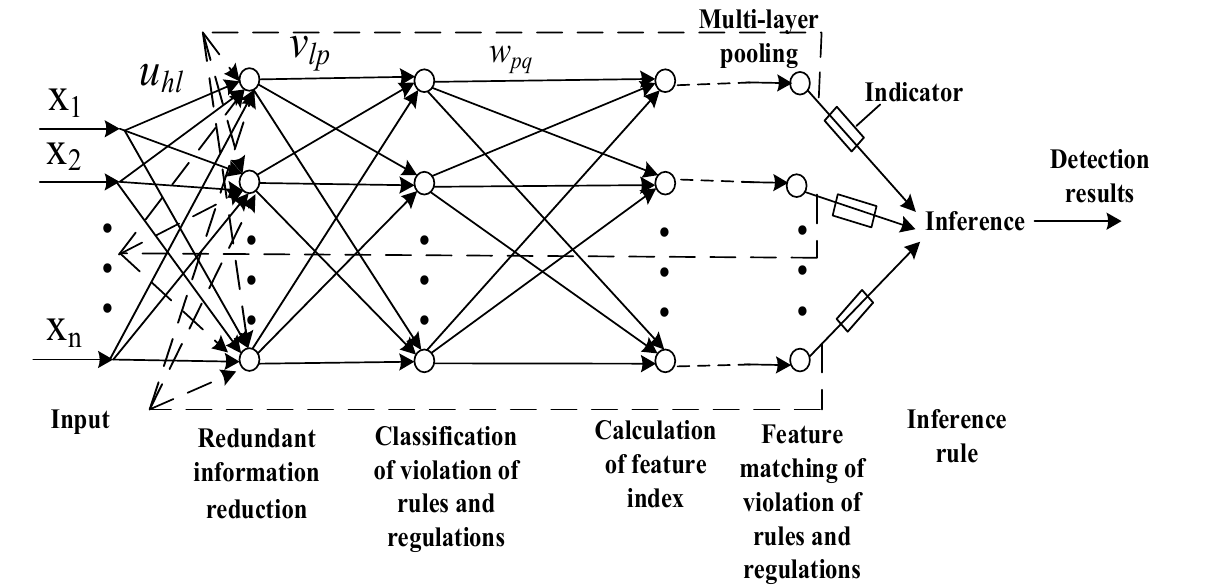
Figure 1. Framework model for safety detection.